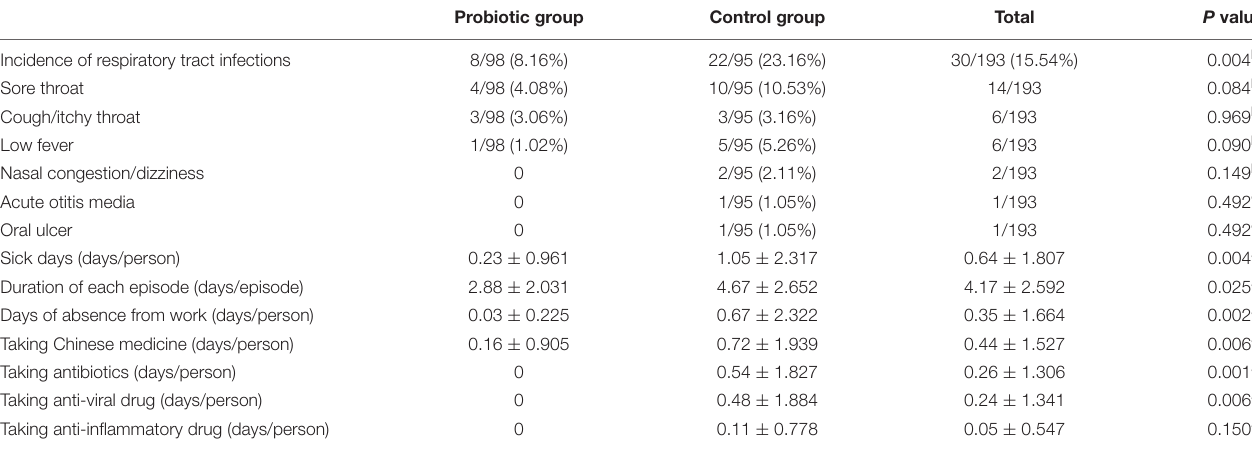
TABLE 2 | The difference analysis of each factor between two groups. Probiotic group Control group Total P value Incidence of respiratory tract